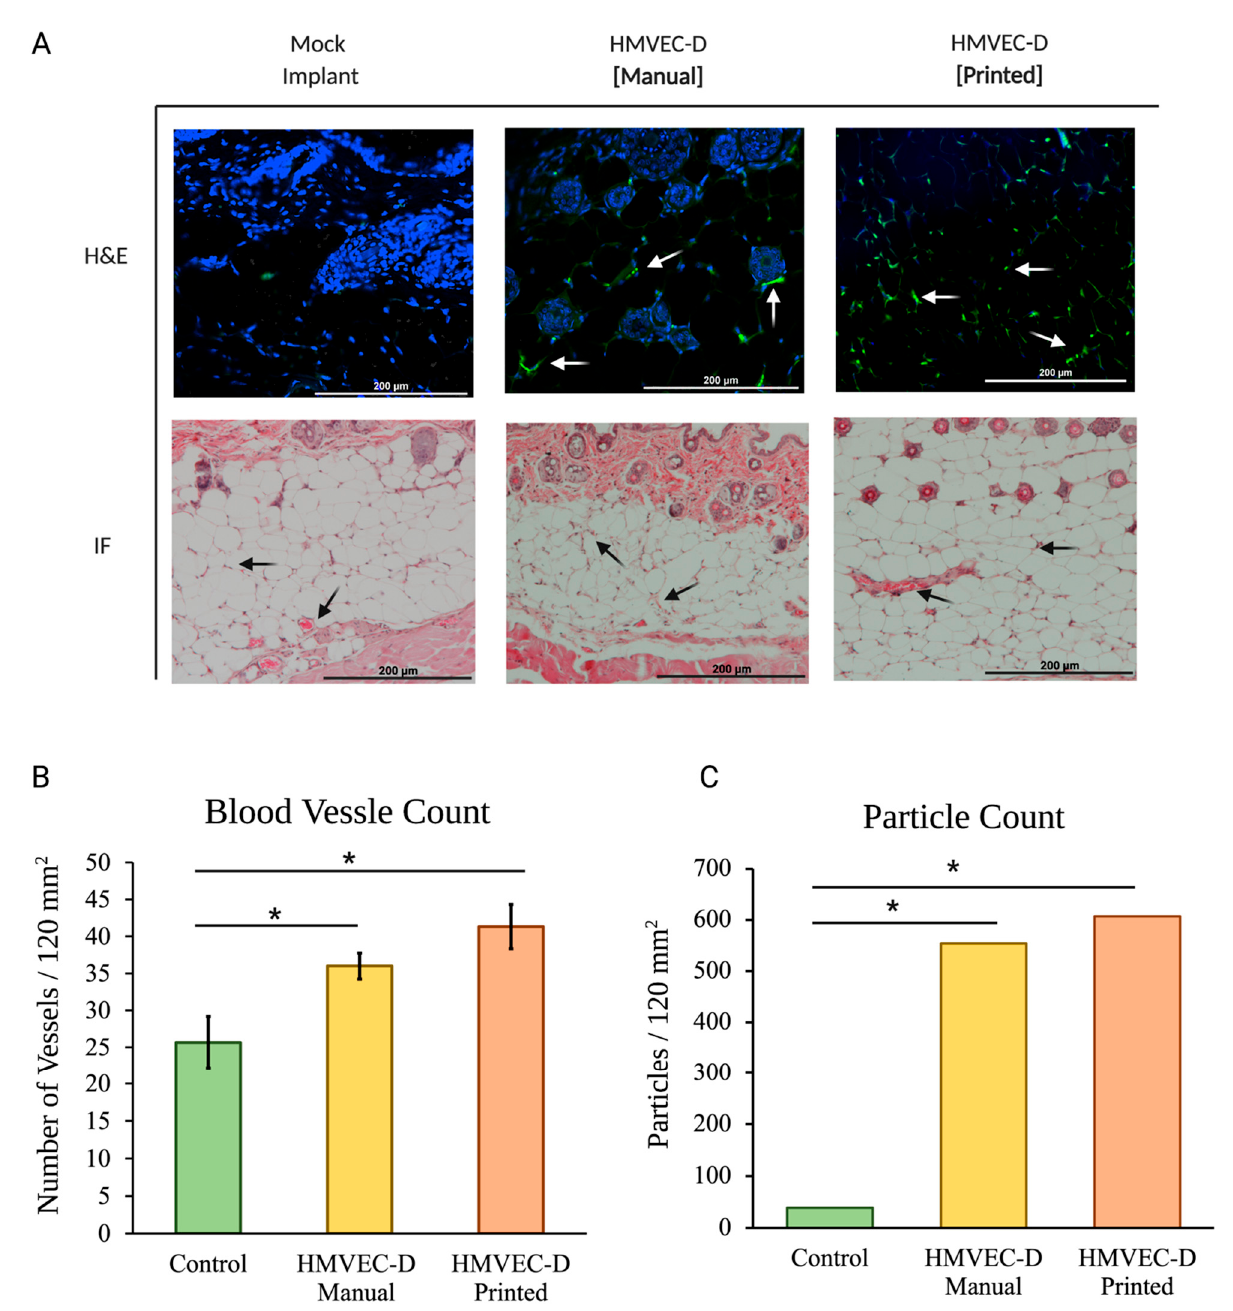
Figure 2. ( A ) In vivo tissue sections of the B17-SCID mice. Hematoxylin, eosin, and immunohistochemistry staining (blue-DAPI, green-CD31) visualize engineered vessels. Arrows indicate microvascular formations. ( B ) Blood vessel quantification of TIB implants show a 1.4 × increase in the number of blood vessels per area compared to the manually made mock implants. The inkjet-printed implants presented 1.77 × more vessels than printed mock implants. ( C ) Particle analysis of CD31-stained tissue samples show a 14 × and 15 × increase for the manually seeded and TIB samples, respectively. * denotes statistical significance p < 0.05